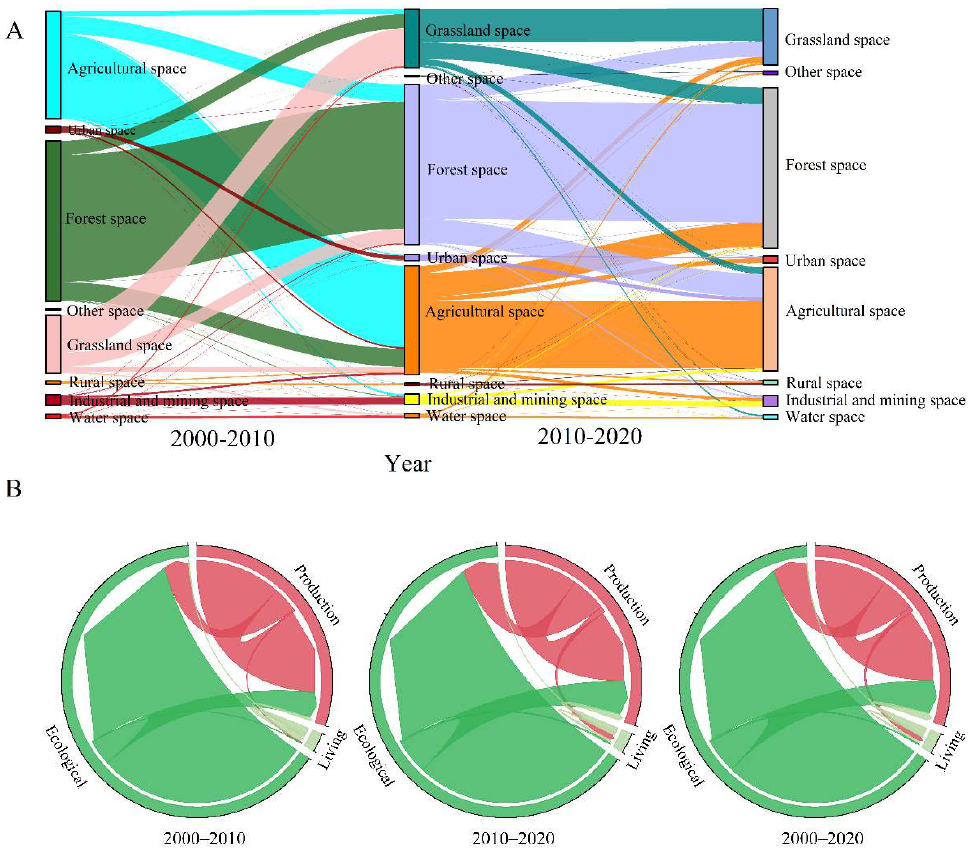
Figure 11. Territorial space type transformation trajectory of the Yangtze River Economic Belt from 2000 to 2020. In the figure, ( A ) is the Sankey diagrams, a visualization of the mutual transfer of territorial space types in the Yangtze River Economic Belt from 2000 to 2020. ( B ) is the chord diagrams, a visualization of the mutual transfer of production, living and ecological space in the Yangtze River Economic Belt from 2000 to 2020. In Figure B, the mutual transfer of production, living and ecological space for 2000–2010, 2010–2020 and 2000–2020 are shown respectively.